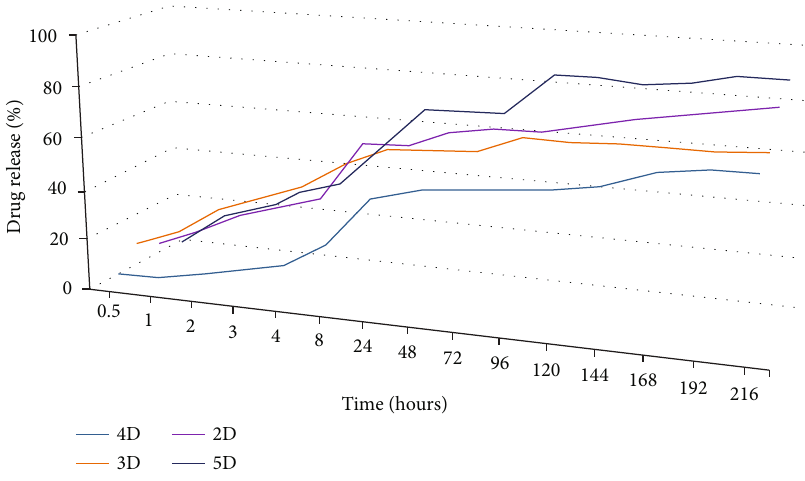
Figure 3: Drug release pro fi le of DCF from formulations and the corresponding exponential trend